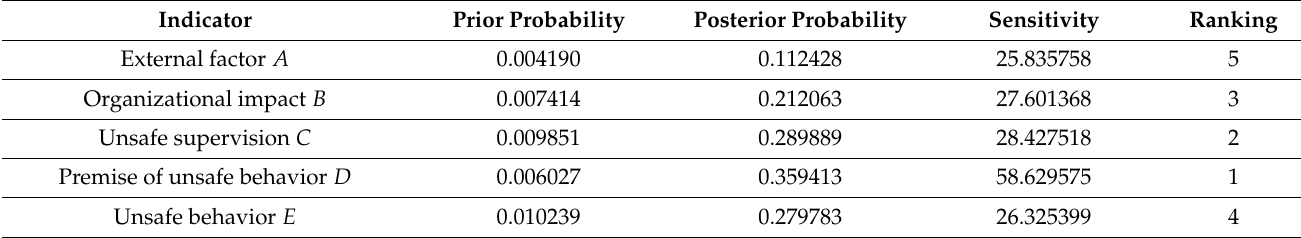
Table 12. Risk factor sensitivity and ranking of each node (first-level indicators).